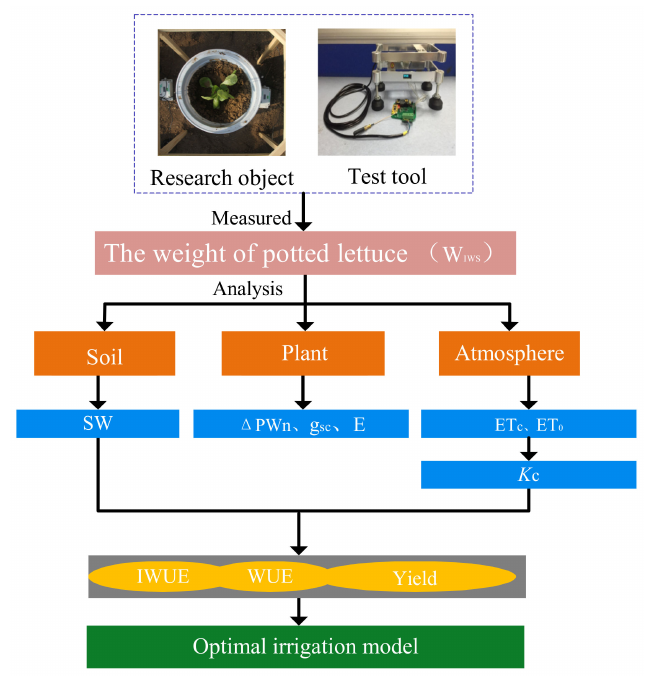
Figure 3. Technology